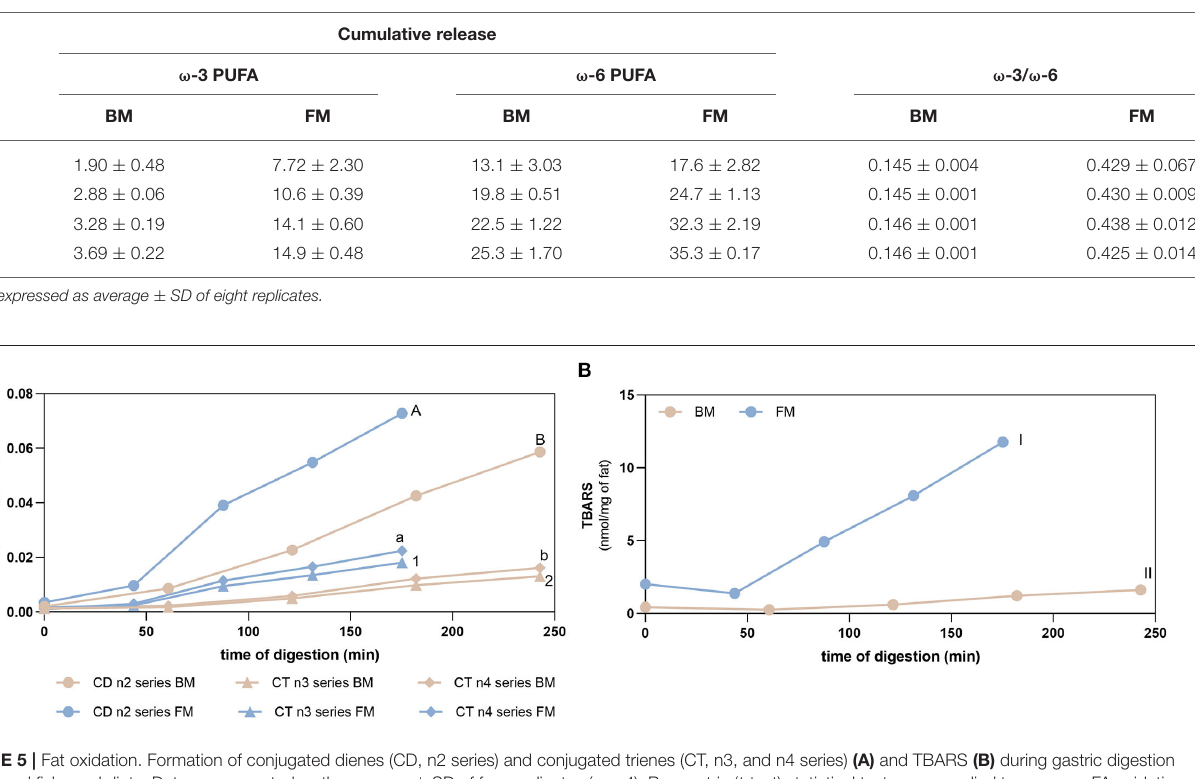
TABLE 2 | Cumulative release (%) of ω -3 and ω -6 PUFA along gastric emptying (GE) for beef meal (BM) and fish meal (FM) diets.